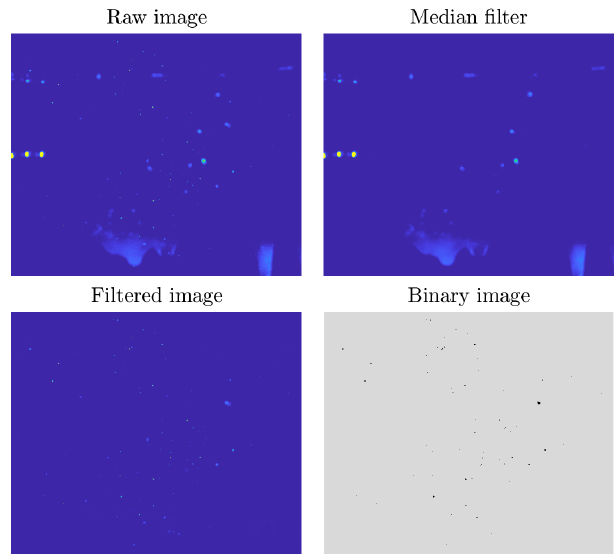
Figure 4. Raw image, median filter, filtered image and final binary image for an example of blowing snow particles. The image size is 2448 pixels × 2048 pixels, corresponding to 82mm × 68 . 6mm. Original MASC images are in gray shades, but the color scheme used here aims to enhance contrast and details for visual purposes.